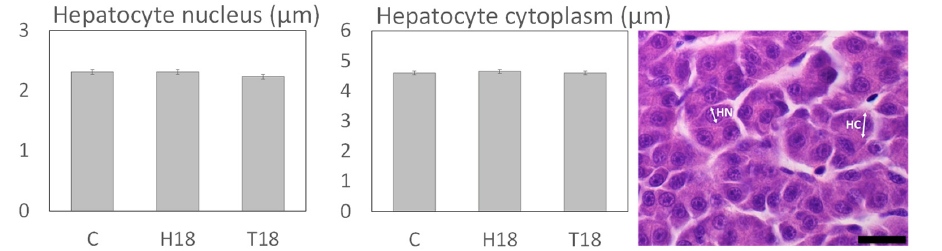
Figure 3. Histomorphology of rainbow trout liver. C: control diet (no IM inclusion); H18: 18 % HI inclusion; T18: 18 % TM inclusion. Values are expressed as mean ± standard error of the mean (SEM; n = 4 tanks per diet, 2 fish per tank). Microphotograph representative of measures for liver: hepatocyte nucleus (HN) and hepatocyte cytoplasm (HC) diameters. Scale bar = 10 µ m.